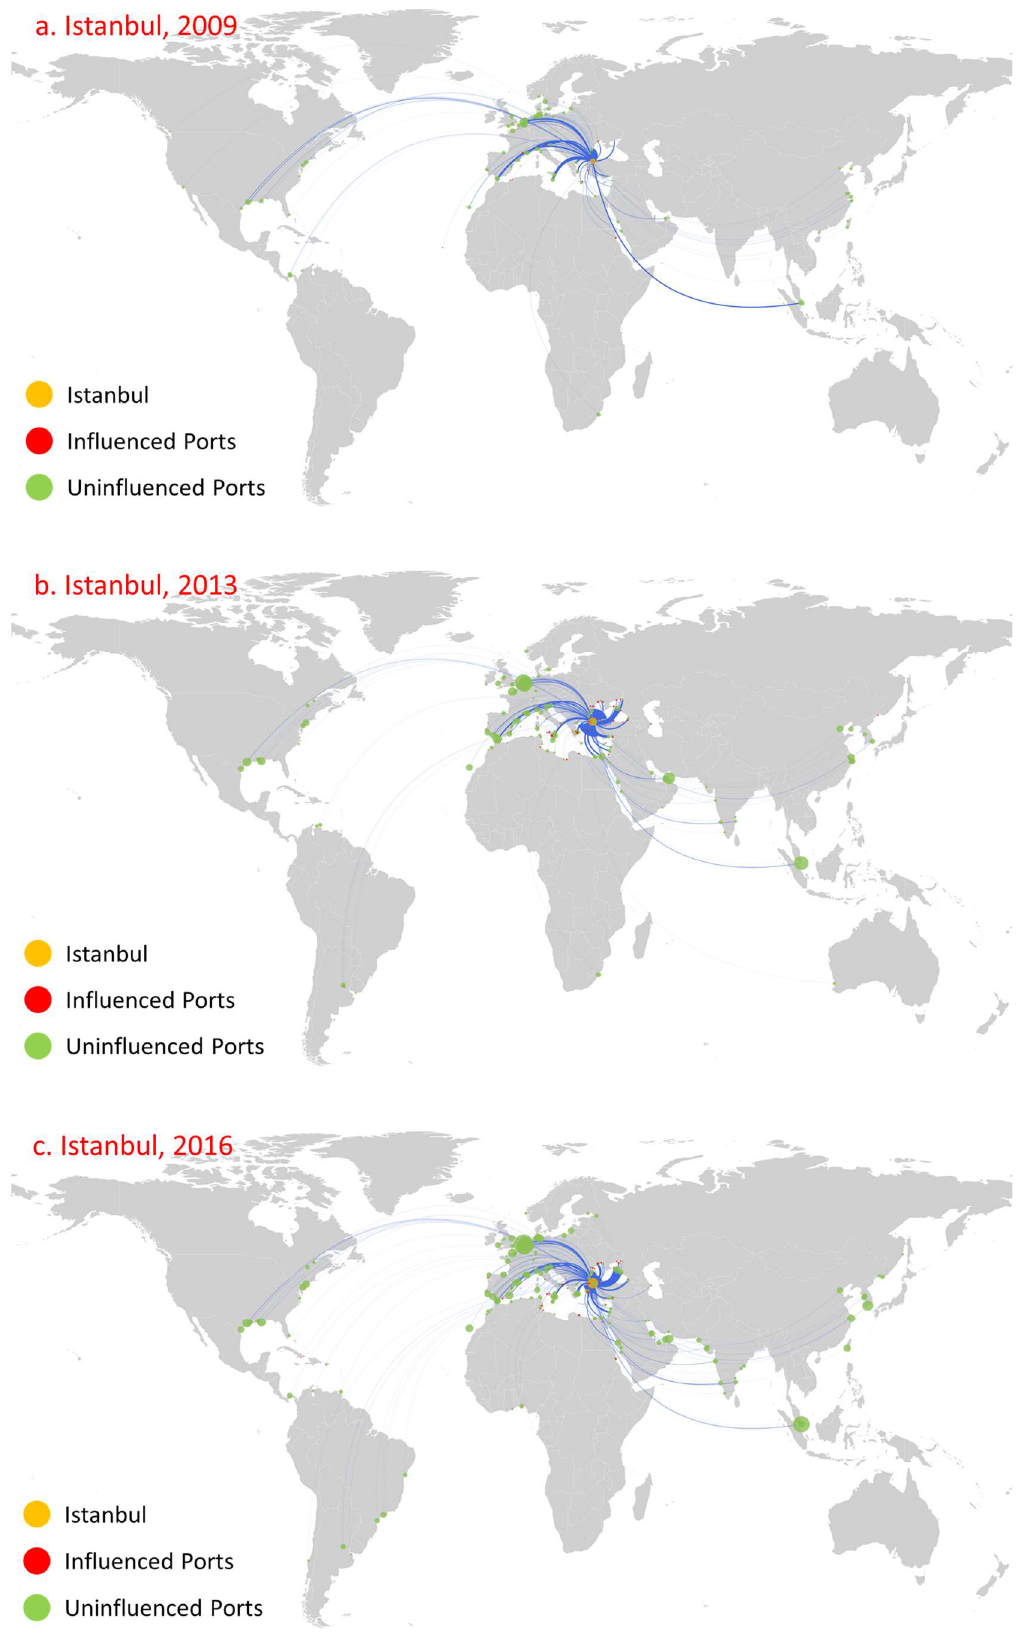
Figure 9. Influence diffusion at the first stage: Istanbul.